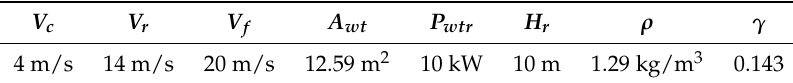
Table 2. Wind turbine modules specifications.